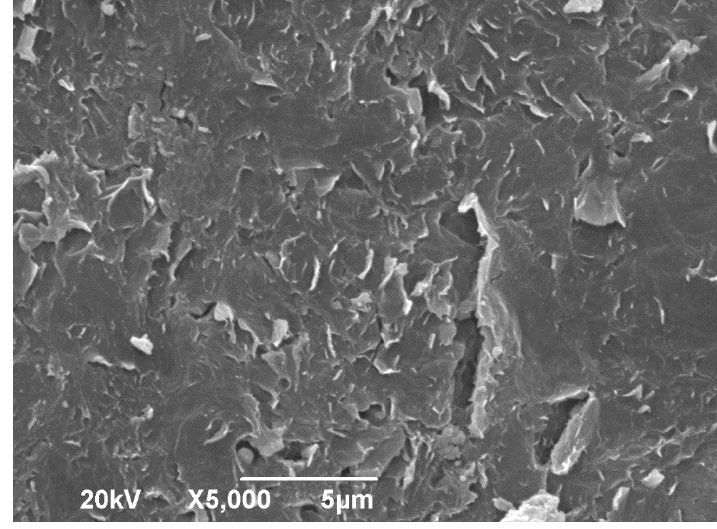
Figure 4. SEM micrograph of the GO.